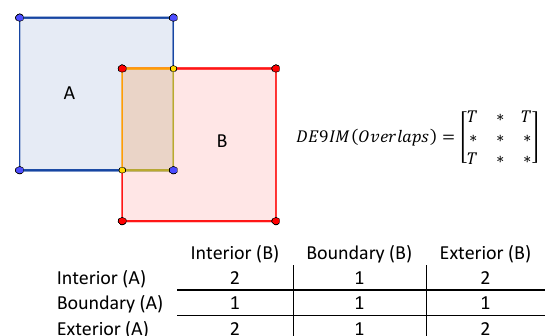
Figure 2. Example of “Overlaps” between 2D regions based on